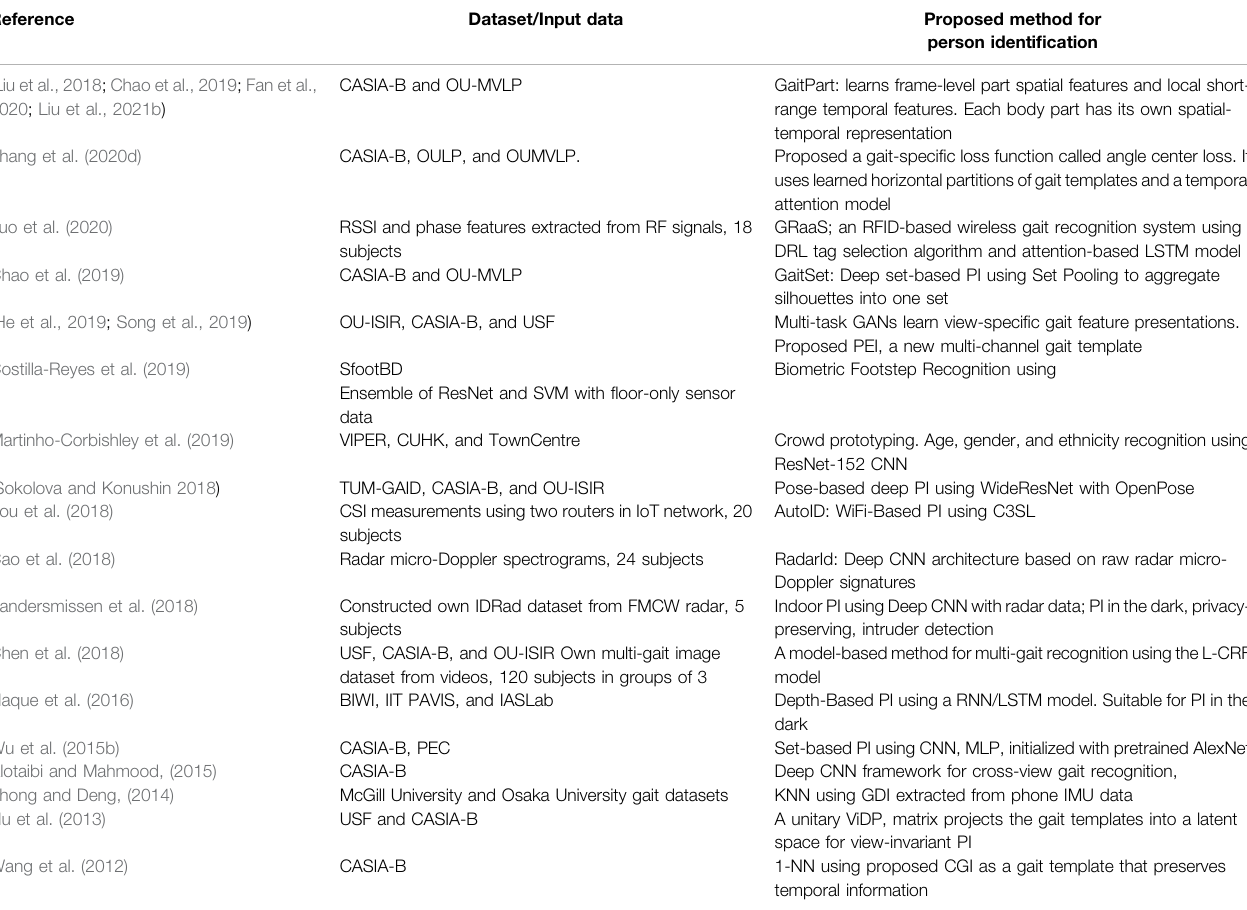
TABLE 8 | Person identi fi cation